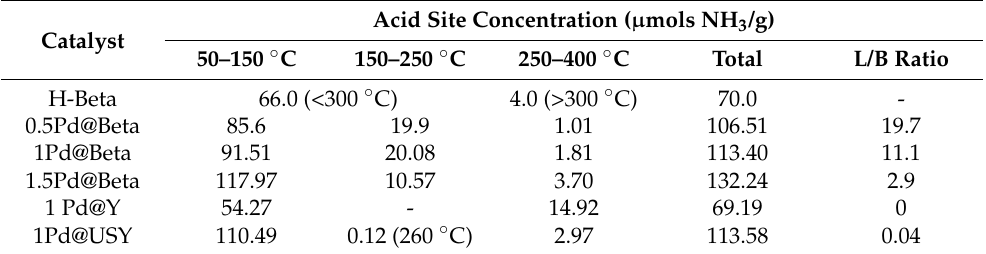
Table 3. Acid site concentration determined through NH3-TPD